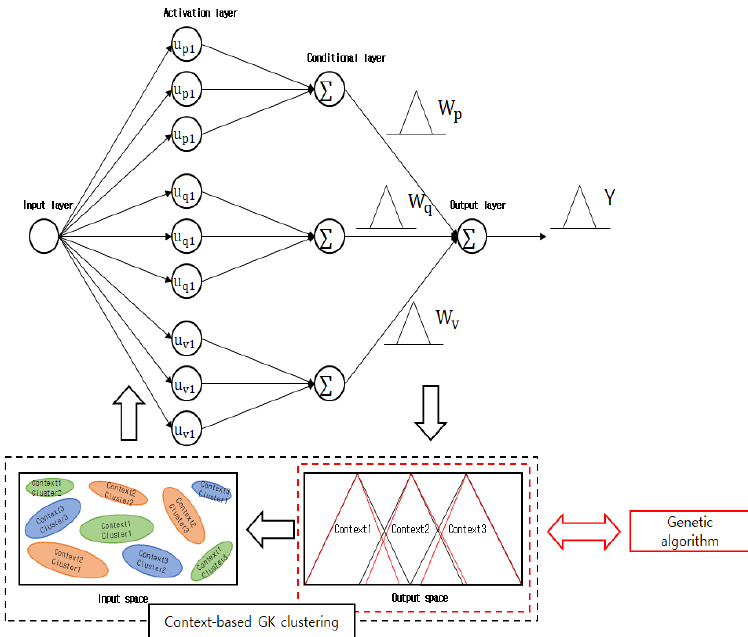
Figure 7. Structure of the optimized CGK-based fuzzy granular model.